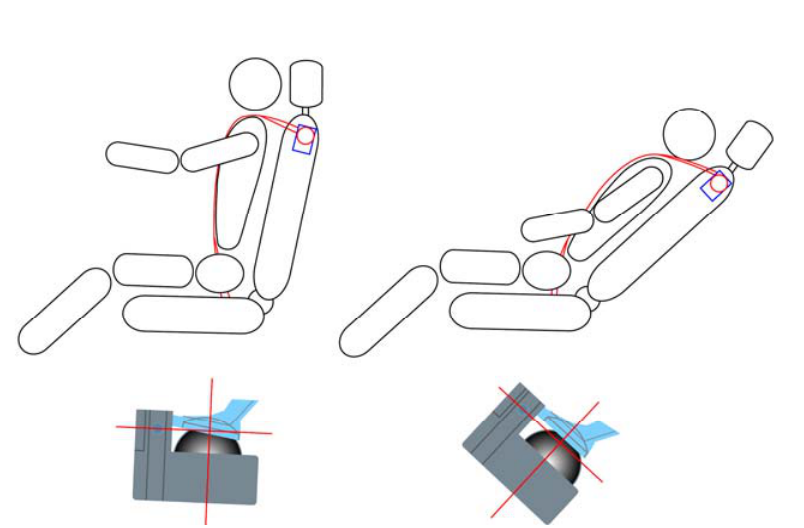
Figure 4. Operation of CG type emergency lock in BIS